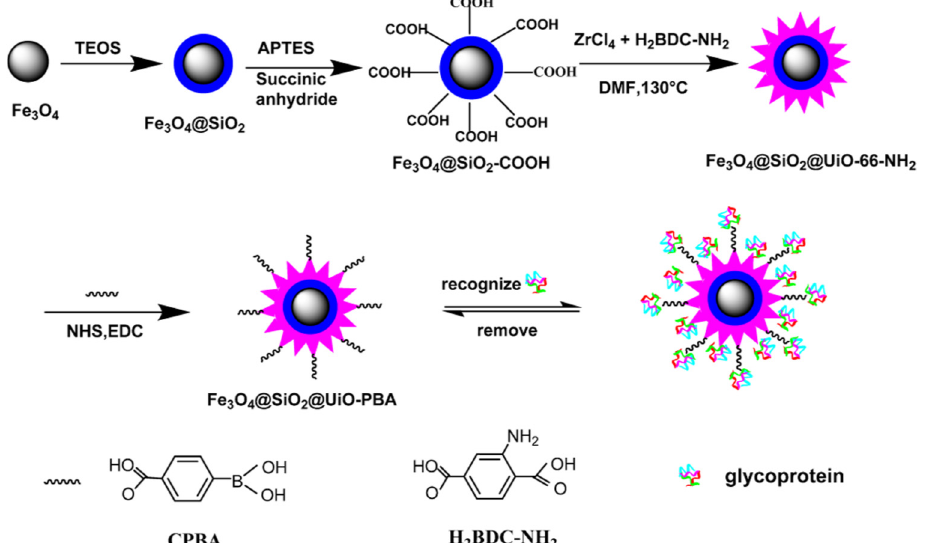
Figure 7. Schematic illustration of synthesis of a dual-functionalized magnetic MOFs nanoparticles by grafting phenylboronic acid onto the surface of UiO-66-NH 2 through amidation reaction. Reprinted with permission from reference [122].